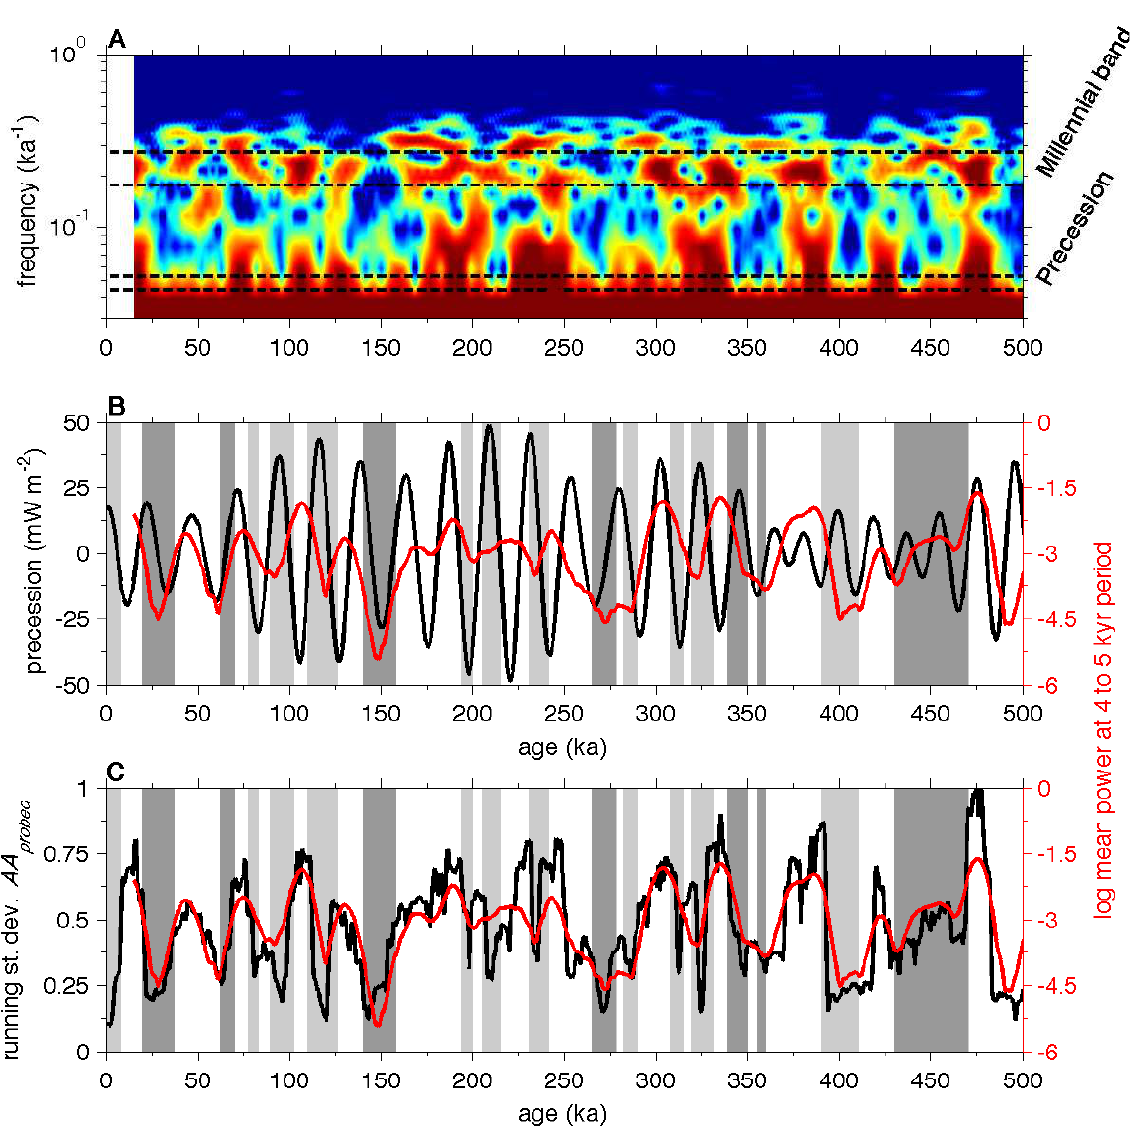
Fig. 3. Alternative analysis using a windowed FFT or spectrogram technique. (A) Spectrogram of AA detrended using a 30kyr window with a 29.999kyr overlap. Dashed lines show precession (19 and 23kyr period) and the millennial band (4 to 5kyr period). (B) The natural log of the mean power in the spectrogram with a period between 3 and 5kyr. Precession forcing from Berger and Loutre (1991) is shown for comparison. (C) The standard deviation of AA probed over 8kyr windows overlapped by 0.1kyr and the natural log of the mean power in the spectrogram with a period between 4 and 5kyr. Light grey bars represent periods of sustained ice sheet growth and the absence of millennial variability and dark grey bars represent periods with ice volume greater than 80 m sea-level equivalent (see Fig. 1e).